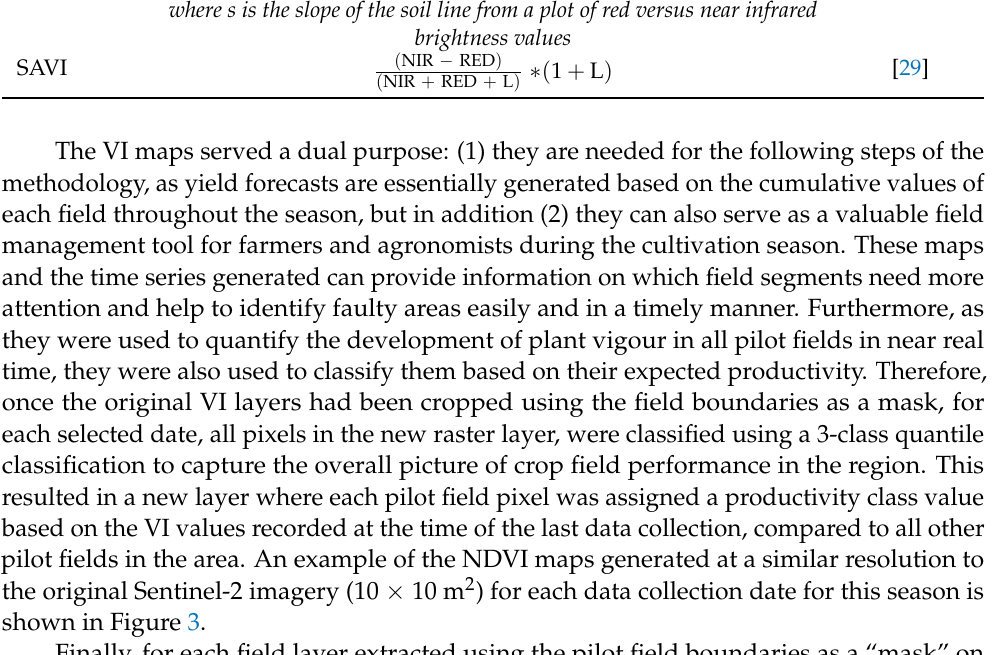
Table 1. The selected Vis used in this study and their respective spectral equations. Index Equation Reference NDVI ( NIR – RED ) ( NIR + RED ) GNDVI ( NIR – GREEN ) ( NIR + GREEN ) NIR − S ∗ RED WDVI where: S is the slope of the soil line from a plot of red versus near infrared. ( NIR − a ∗ RED − b ) √ ( a Λ 2 + 1 ) PVI where a is the slope of the ground line and b is the ground line’s gradient. ( NIR − RED ) ∗ ( 1 + L )) ( NIR + RED + L ) where : L = 1 − ( 2 ∗ s ∗ ( NIR − RED ) ∗ ( NIR − s ∗ RED )) MSAVI ( NIR + RED ) where s is the slope of the soil line from a plot of red versus near infrared brightness values